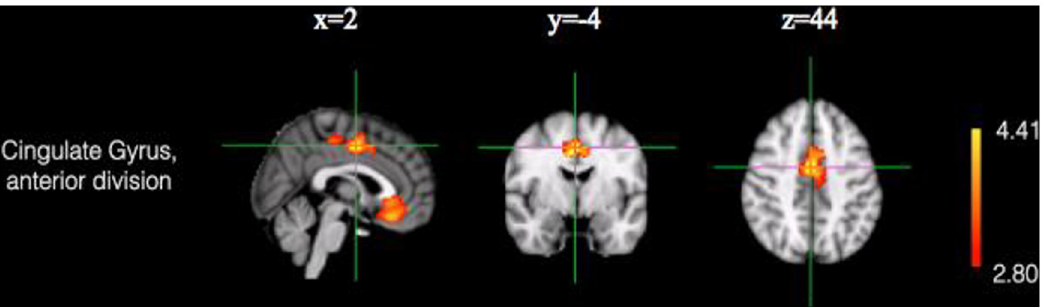
Fig 3. Region demonstrating a significant larger cluster for gray matter volume for AIDS orphans in comparison to the control group (adjusted for total gray matter volume, age and gender; cluster-based correction, p = 0.005).